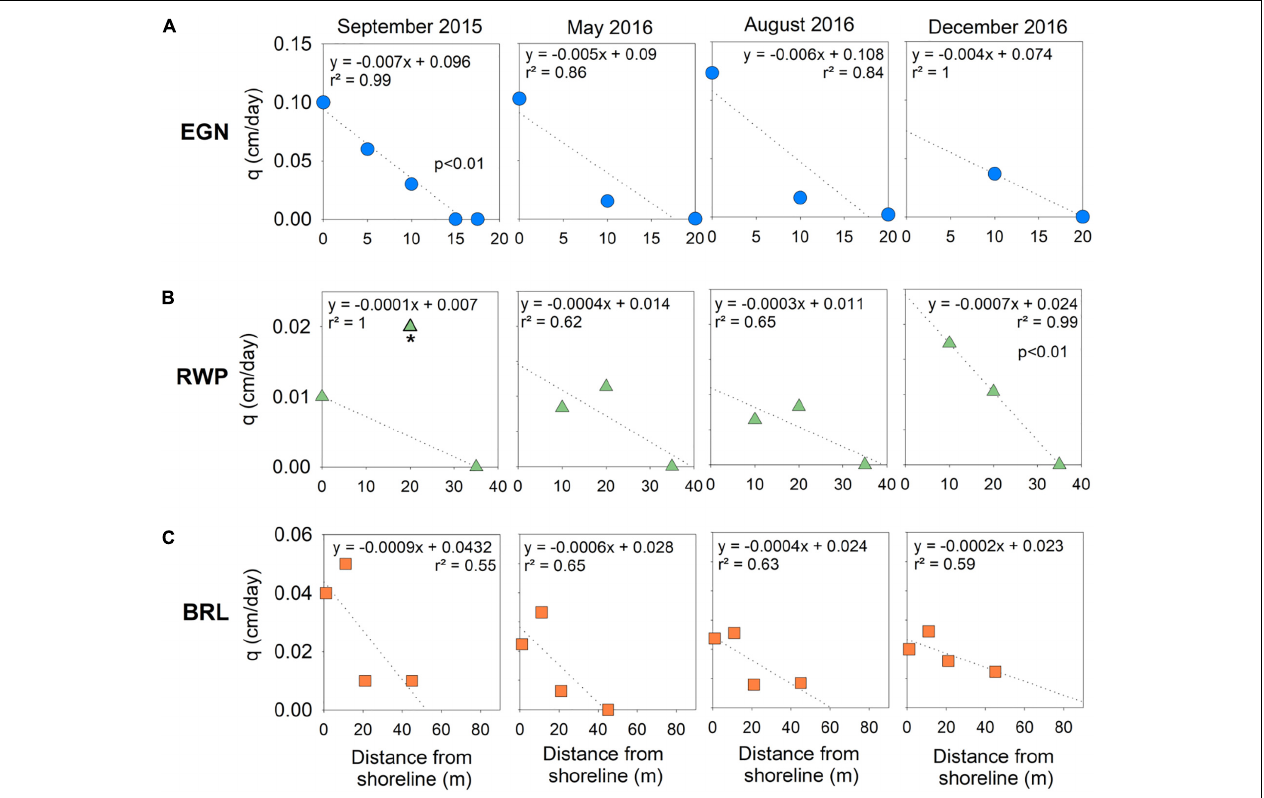
FIGURE 2 | Specific discharge (q) versus distance offshore over time for (A) EGN, (B) RWP, and (C) BRL. Regression lines are indicated with dotted lines. Regression lines include all data available except for the most distal piezometer at EGN (17.5 m offshore) in September 2015, as both the 15- and 17.5-m offshore piezometers had zero groundwater specific discharge. RWP-20 is not included in September 2015 discharge estimates because its inclusion forces the x-intercept to extend beyond RWP-35, where zero advective flow was calculated based on porewater chloride profiles. P -values are only indicated where the correlation between variables is